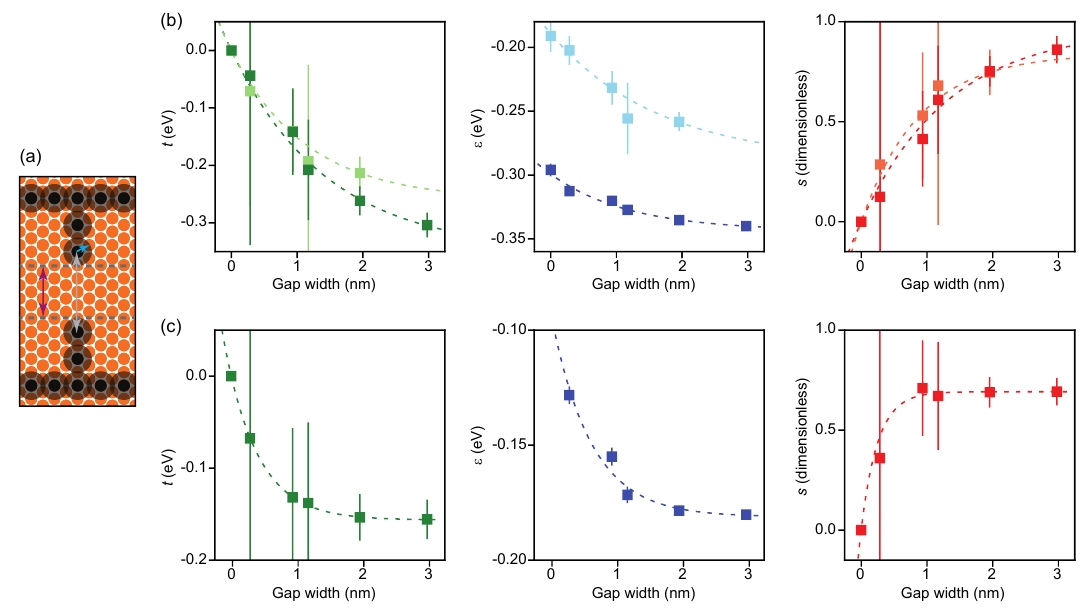
Figure 7: (a) The size of the gap in the barrier between the two corrals (red arrow) is the distance between the closest CO molecules in the barrier (gray arrow), minus two times the apparent size of the CO molecules (gray circle, blue arrow, 0.3 nm). (b) From left to right: gap dependence of the hopping parameter, the on-site energy and overlap for s -like states, respectively. Dark and right colors represent data from (cid:112) (cid:112) rectangular corrals with sizes 8 3 a × 14 a and 6 3 a × 10 a , respectively. (c) Same as (b) but now for p -like